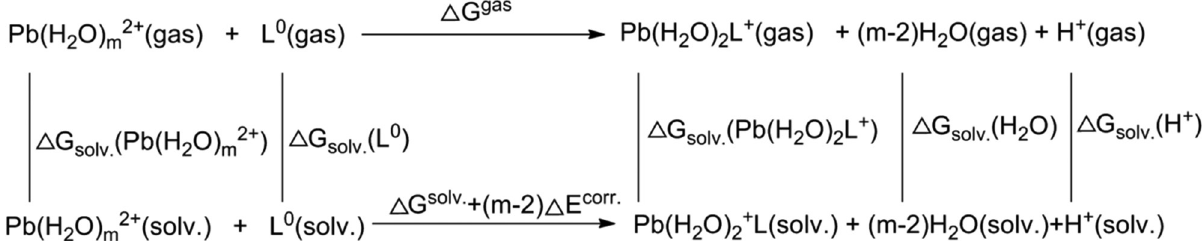
Scheme 2: Thermodynamic cycle for the calculation of logK calc .